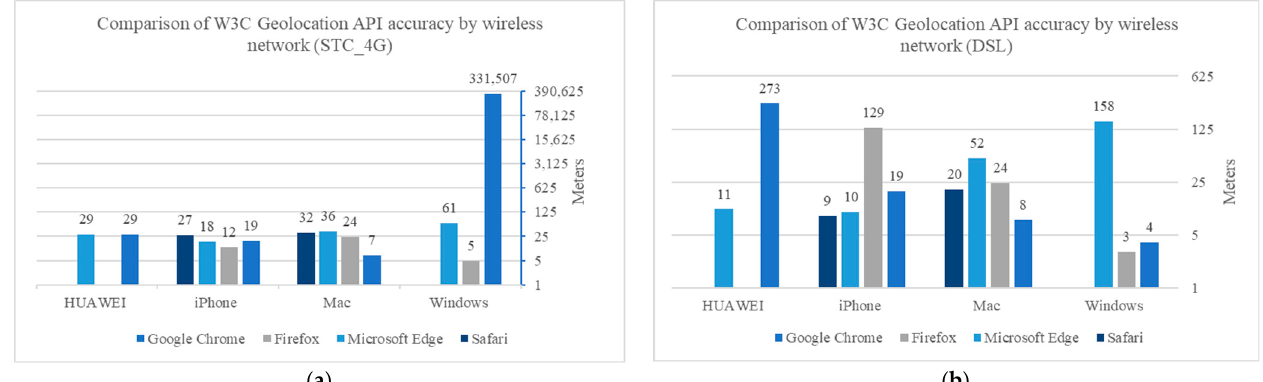
Figure 5. Comparison analysis of the W3C geolocation API method. ( a ) Comparison of W3C Geolocation API accuracy by wireless network (STC_4G); ( b ) Comparison of W3C Geolocation API accuracy by wireless network (DSL)